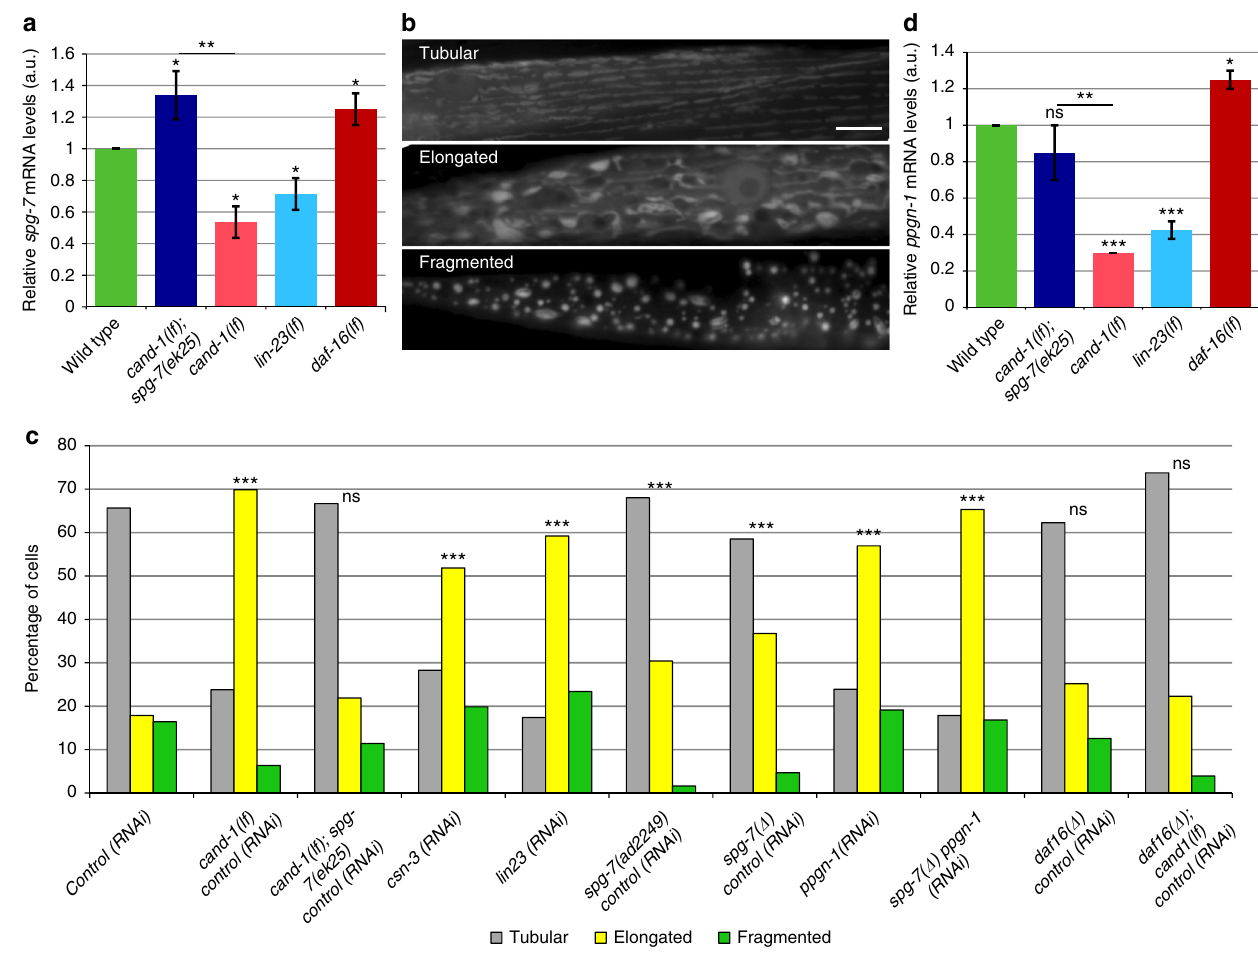
Fig. 1 CAND-1/SCF LIN-23 regulates mitochondrial shape via spg-7 and ppgn-1 . a Real-time PCR quanti fi cation of spg-7 mRNA levels in adults of the indicated genotypes, presented in arbitrary units (a.u.) normalized to control rpl-19 (ribosomal protein L19) mRNA. Error bars denote s.e.m. from four biological replicates, each with at least two technical replicates. P values were determined by Student ’ s t -test. b Images of tubular, elongated, and fragmented mitochondria visualized by mitochondria-targeted GFP expressed in body-wall muscle cells. Scale bar , 10 µ m. c The percentages of muscle cells with tubular, elongated, and fragmented mitochondria for the indicated genotypes and RNAi treatments. All animals were fed either gene-speci fi c RNAi or control RNAi so that the feeding conditions were matched. P values were determined by χ 2 -test. Sample size ( n ) of muscle cells from left to right are: 729; 126; 210; 124, 210; 201; 234; 274; 209; 297; 318; 457. Mitochondrial morphology was scored blinded. d Real-time PCR quanti fi cation of ppgn-1 mRNA levels normalized to control rpl-19 mRNA in adults of the indicated genotypes. Error bars denote s.e.m. from three biological replicates, each with at least two technical replicates. P values determined by Student ’ s t -test. For all panels , asterisks above bars denote P value comparisons to wild-type/controls; asterisks above lines denote comparisons under the lines: * P < 0.05; ** P < 0.01; *** P < 0.001; ns = not signi fi